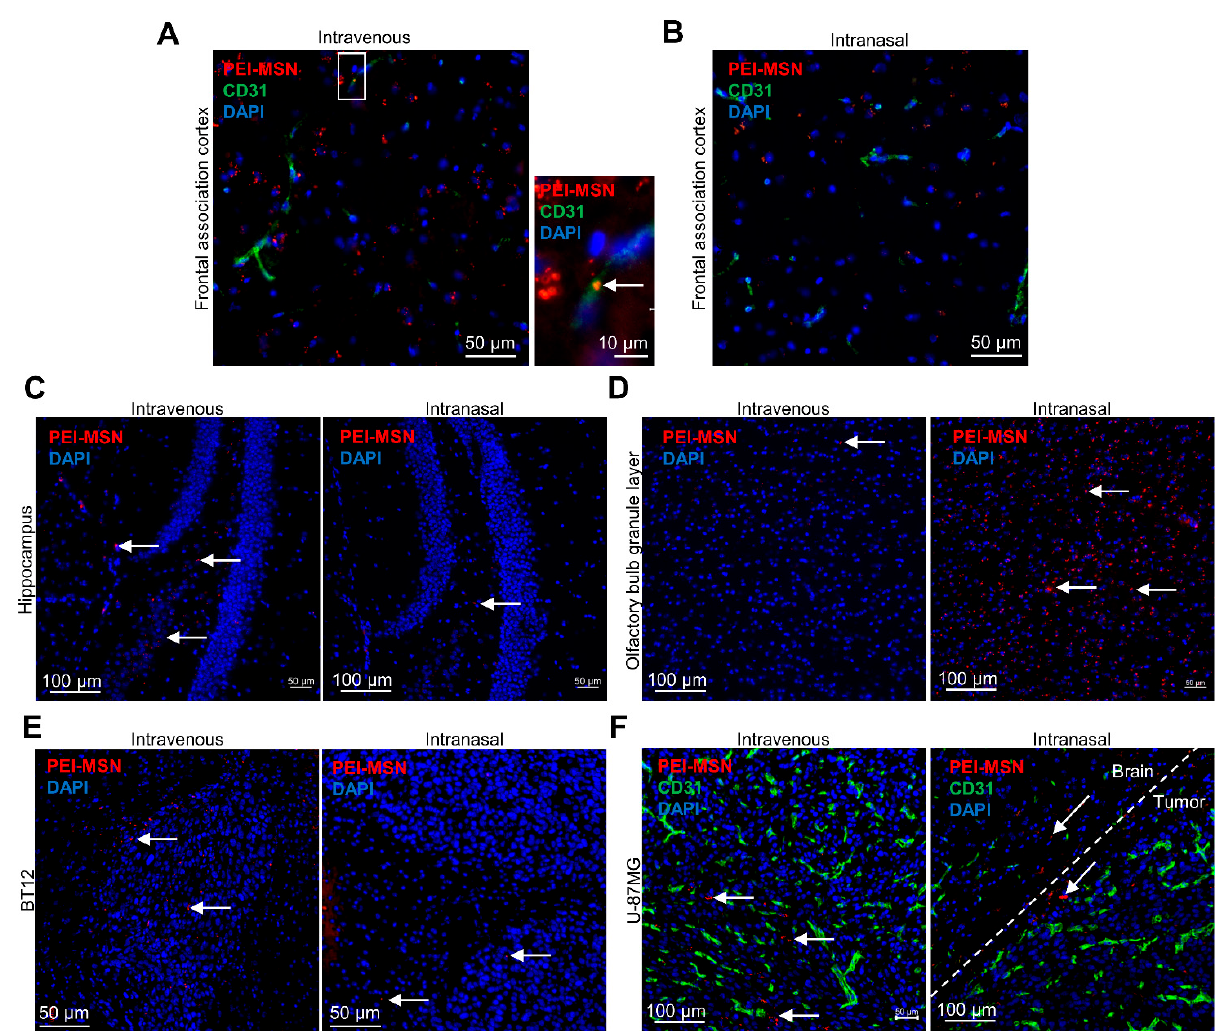
Figure 10. The PEI-MSNs can be delivered to the brain in vivo. ( A , B ) Confocal images of the colocalization of PEI-MSNs (red) with the endothelial cell marker CD31 (green) in the frontal association cortex of mice injected with 100 µg of PEI-MSNs in the caudal vein ( A ) ( n = 5), or with 3 dosages of 35 µg of PEI-MSNs given intranasally ( B ) ( n = 5). After 8 h, PEI-MSNs were found associated with the brain endothelium ( A , arrow right panel) and in the brain parenchyma. ( C ) Confocal images of the PEI-MSNs (arrows, red) in the hippocampus area of IV-injected (left) or intranasally administered mice (right). ( D ) Confocal images of the PEI-MSNs (arrows, red) in the olfactory bulb granular layer of IV-injected (left) or intranasally administered mice (right). ( E ) Confocal images of the PEI-MSNs (arrows, red) IV-injected (left) or intranasally administered (right) to mice, xenografted with BT-12 cells. Cell nuclei are counterstained with DAPI. ( F ) Confocal images of the PEI-MSNs (arrows, red) IV-injected (left) or intranasally administered (right) to mice, xenografted with U-87MG-GFP cells. Cell nuclei are counterstained with DAPI and blood vessels labeled with anti-CD31 (green).